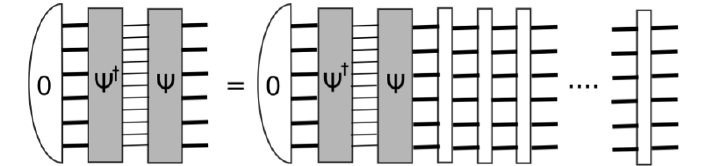
(cid:12) (cid:12) (cid:12) (cid:11) (cid:11) (cid:11) and . Since is (cid:12) 0 (cid:12) E; (cid:27) (cid:12) 0